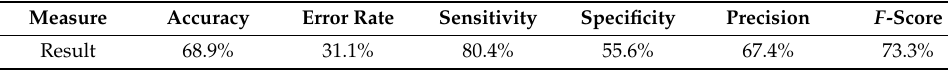
Table 8. Evaluation measures for the SIFT over the 1500 patches.